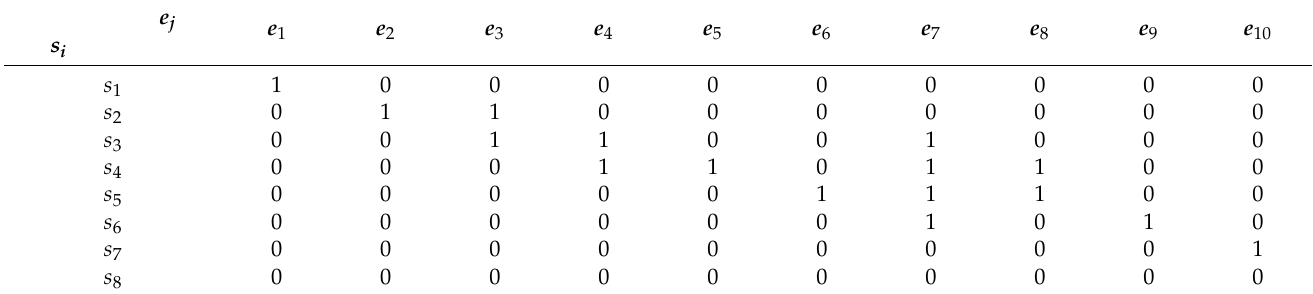
Table 3. Independent cut set–branch incidence matrix (corresponding to Figure